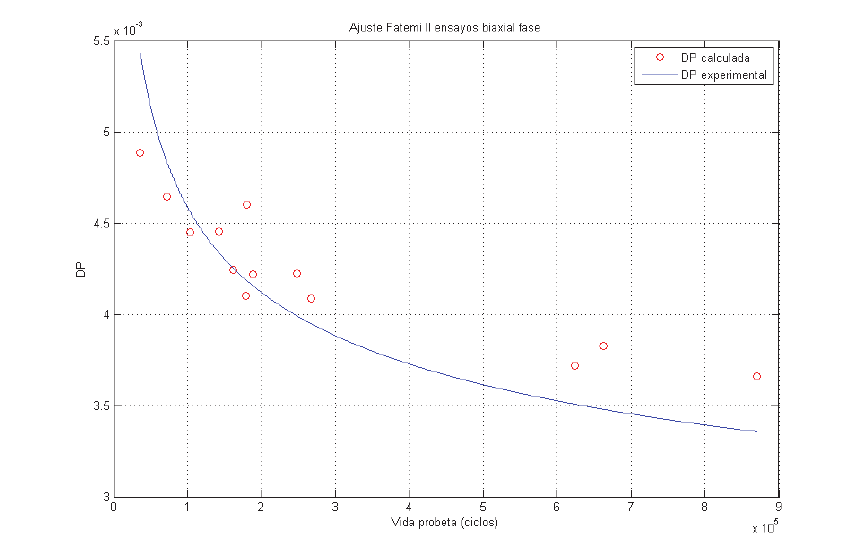
Figure 3: Fatigue life correlation for St52-3N steel based on Fatemi II